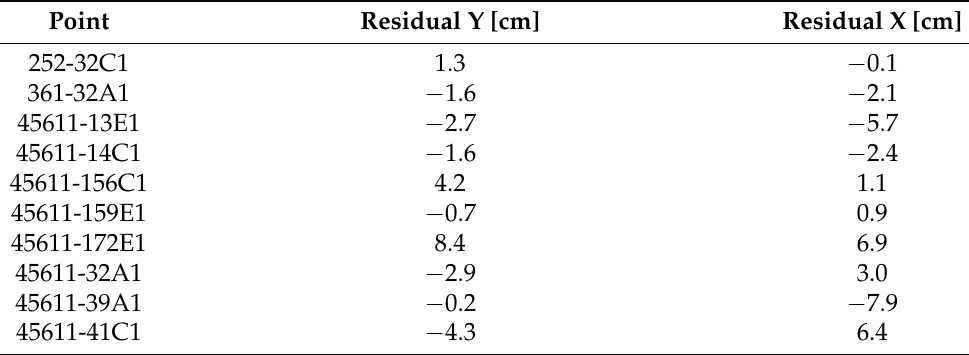
Table 3. Residuals of control points after conformal